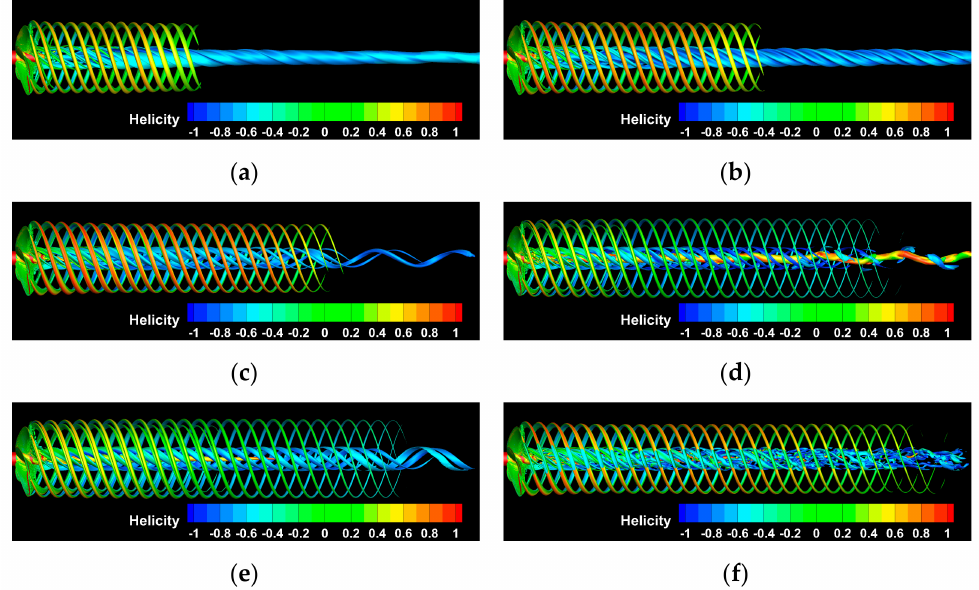
Figure 7. Vortices released by the KP505 propeller working in open water computed as iso-surfaces of Q = 15,000. ( a ) J = 0.1, ( b ) J = 0.3, ( c ) J = 0.5, ( d ) J = 0.7, ( e ) J = 0.8, ( f ) J =